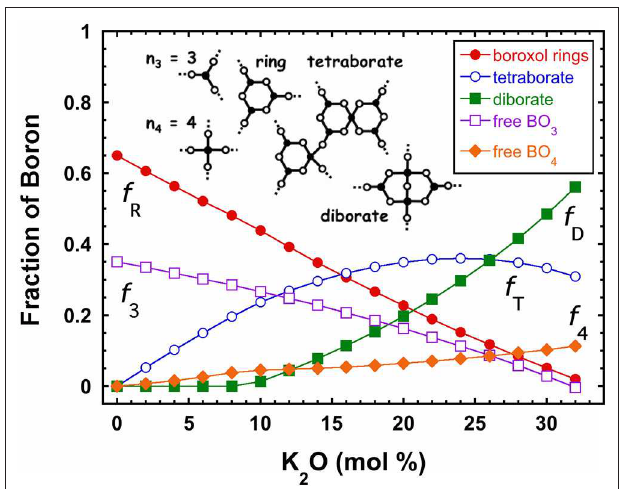
FIGURE 7 | The fragility index of lithium and sodium borate glasses (Nemilov, 1966; Chryssikos et al., 1994 ) is plotted as a function of the connectivity coarse-grained to include IRO structures. Also shown are the data from Figure 4 for both the chalcogenides (plotted as a function of the average bond per atom) and the alkali phosphates (plotted as a function of the average BO per phosphate). The inset shows how the coarse-grained connectivity of the borates decreases with increasing alkali oxide